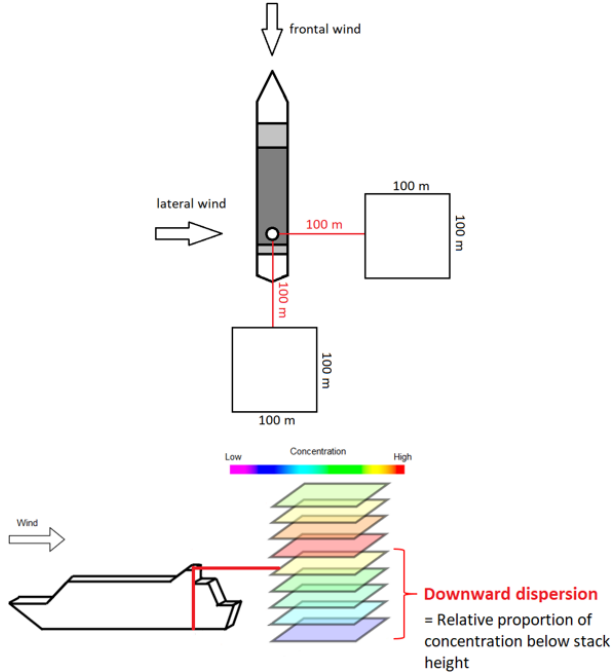
Figure 4. Schematic sketches of the investigation area. Vertical con- centration profiles are evaluated at a distance of 100m downwind of the ship for layers of 100m × 100m.